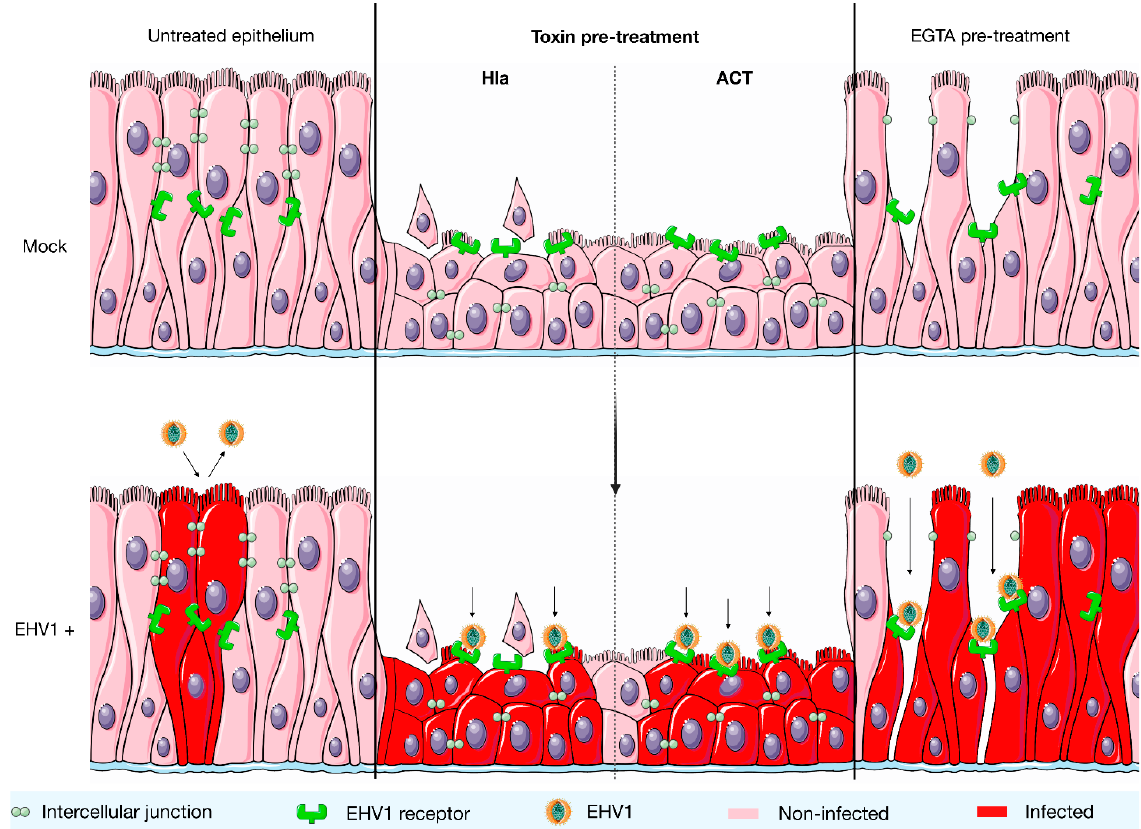
Figure 3. A hypothetical model on how exposure to Hla and ACT toxins might drive subsequent EHV-1 infection in the equine respiratory epithelium. Left: in normal healthy epithelium, EHV-1 replication is restricted due to the fact it targets a receptor located at the basolateral surface of the epithelial cells. This receptor is shielded from the apical environment by cellular junctions. Middle: after treatment with the Hla or ACT toxin, the epithelium undergoes morphological changes, characterized by a decrease in epithelial thickness. It may be that due to a remodeling of the actin cytoskeleton, the EHV-1 receptor becomes available near the apical side of the epithelium. This may explain the more efficient EHV-1 replication. Right: treatment with EGTA was included in this study as a positive control and leads to the disruption of cell junctions. Destruction of epithelial junctions drives EHV-1 infection by providing the virus free access to its basolateral receptor.